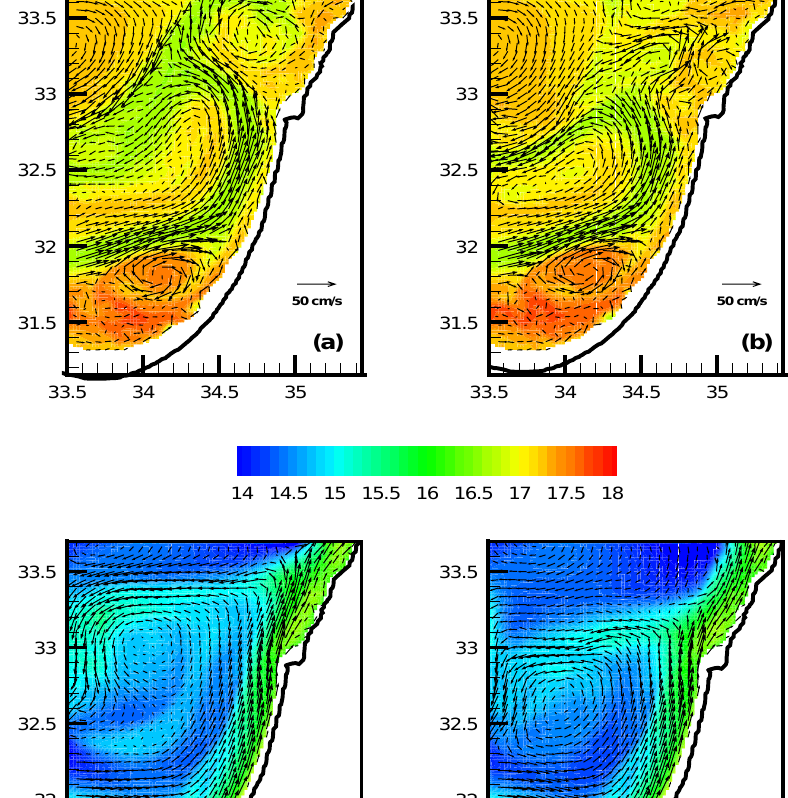
Fig. 4. Simulated potential temperature and velocity at 30m: (a) 20 August of the second year, (b) 20 August of the third year.